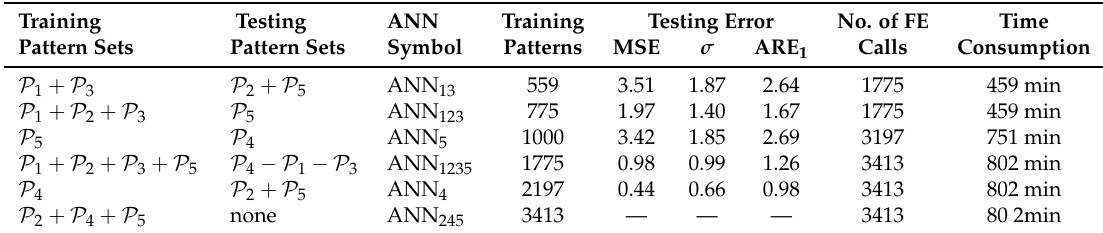
Table 4. Deep network training and testing